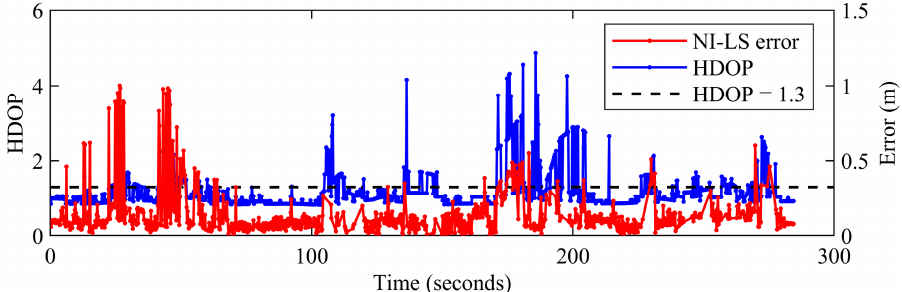
Figure 11. Time series of the HDOP value (blue) and the NI-LS method error (red).